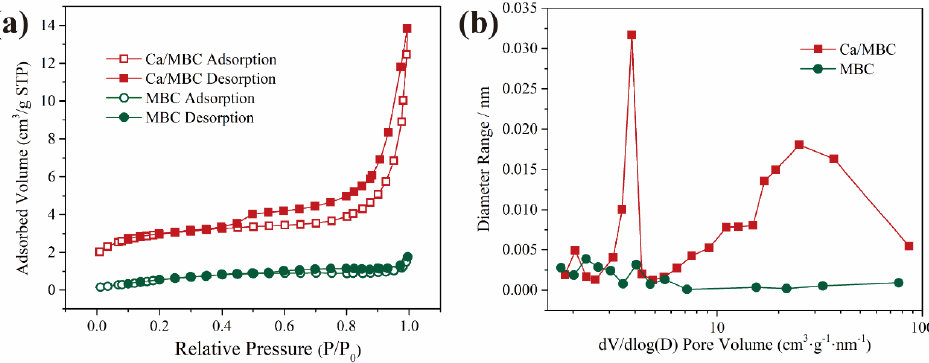
Figure 4. N 2 adsorption-desorption isotherms ( a ) and pore size distributions ( b ) of MBC and Ca/MBC.